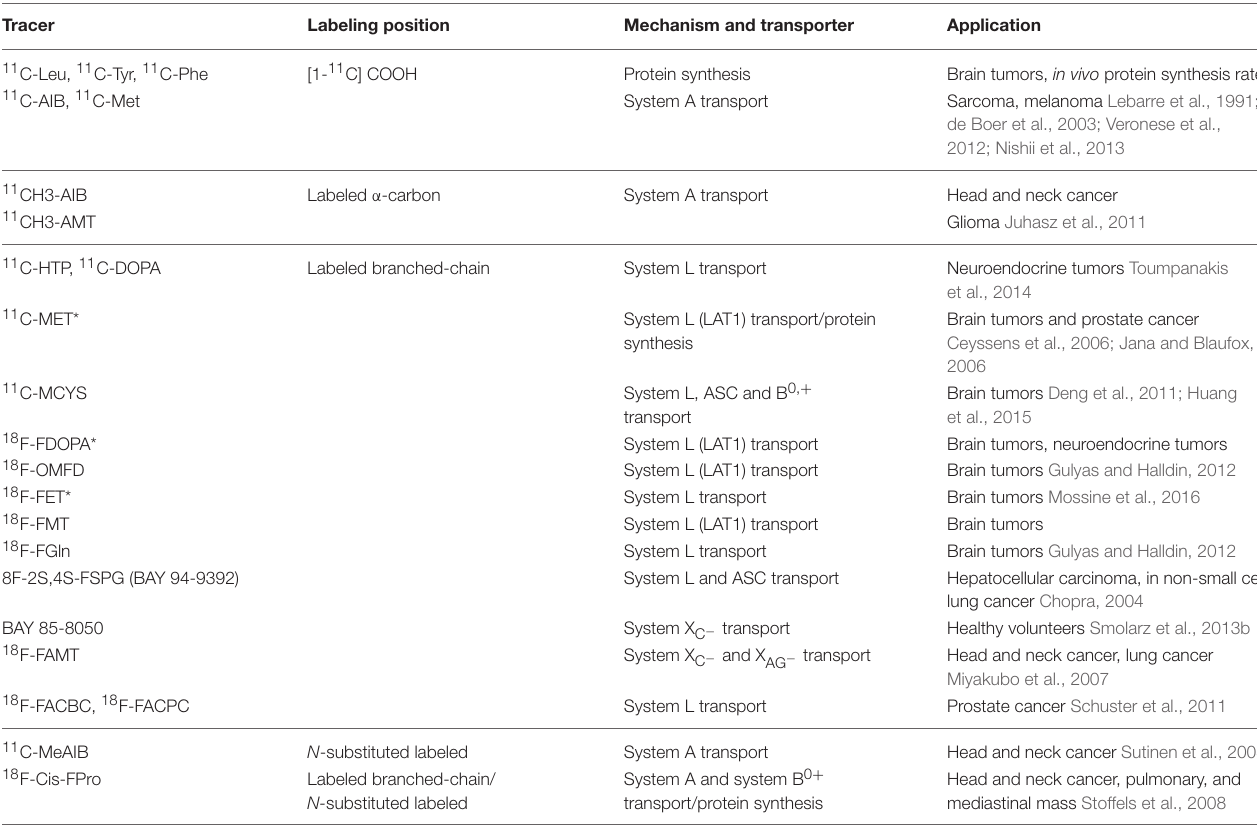
TABLE 2 | Uptake mechanism and clinical application of important AA PET tracers for tumors imaging.